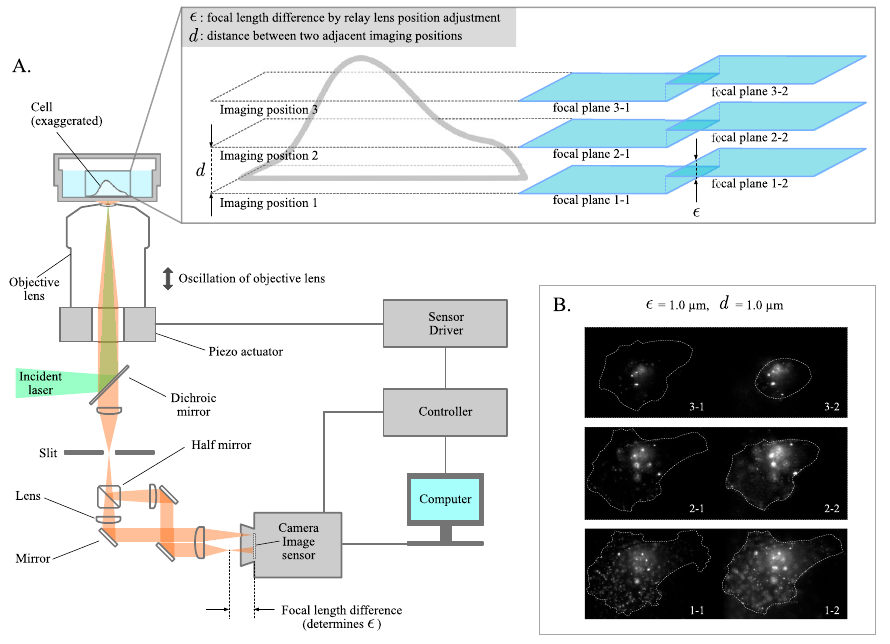
Figure 2. Overall concept of combined dual-focus optics with objective lens oscillation. ( A ) Schematics of optical path and objective lens-mounted piezo actuator system. For dual-focus optics in fluorescence microscopy, light reflected from the labeled organelle in the sample cell is divided by two optical paths having different focal lengths, adjusted by the position of relay lenses [11]. The difference in focal length created by the lens position determines the distance (cid:101) . The distance d is determined by the axial position of objective lens, the step size of which can be controlled by an external controller; ( B ) Cell images taken at each imaging positions for (cid:101) = d =